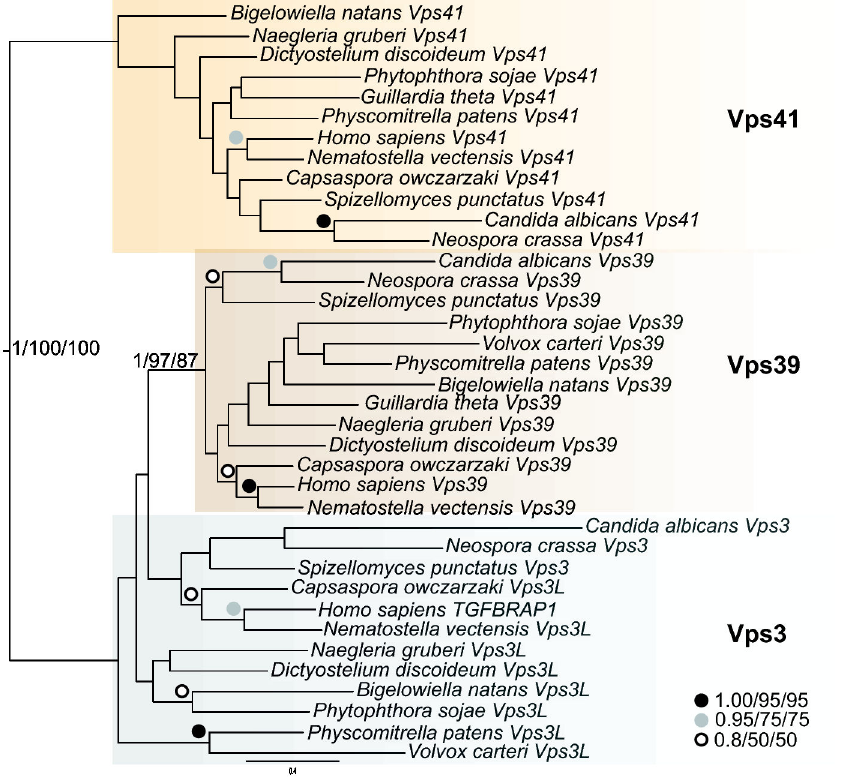
Figure 3. Phylogenetic analysis of Vps3, Vps39, and Vps41 proteins from select taxa. This figure demonstrates the separation of select Vps proteins from taxa spanning the breadth of eukaryotic diversity into distinct clades. Colour-coding is arbitrary and for visual purposes